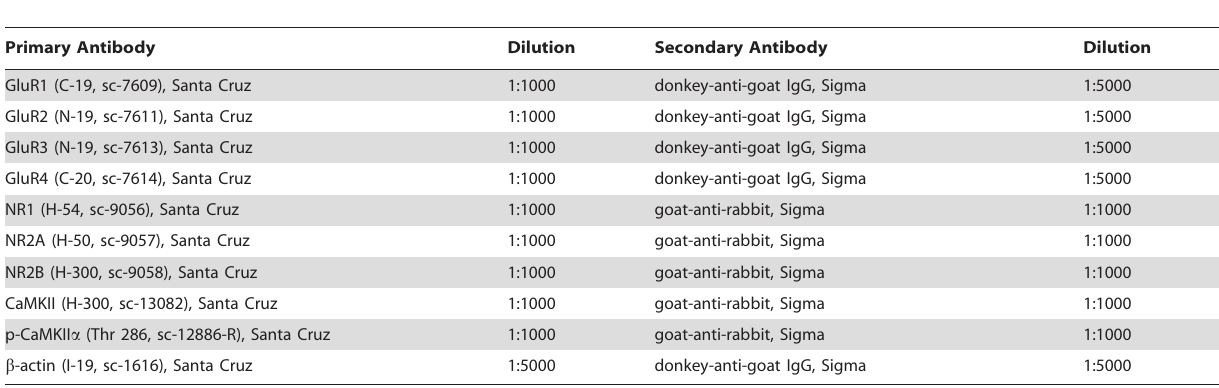
Table 1. Details of the primary and secondary antibodies used in the western blotting experiments.